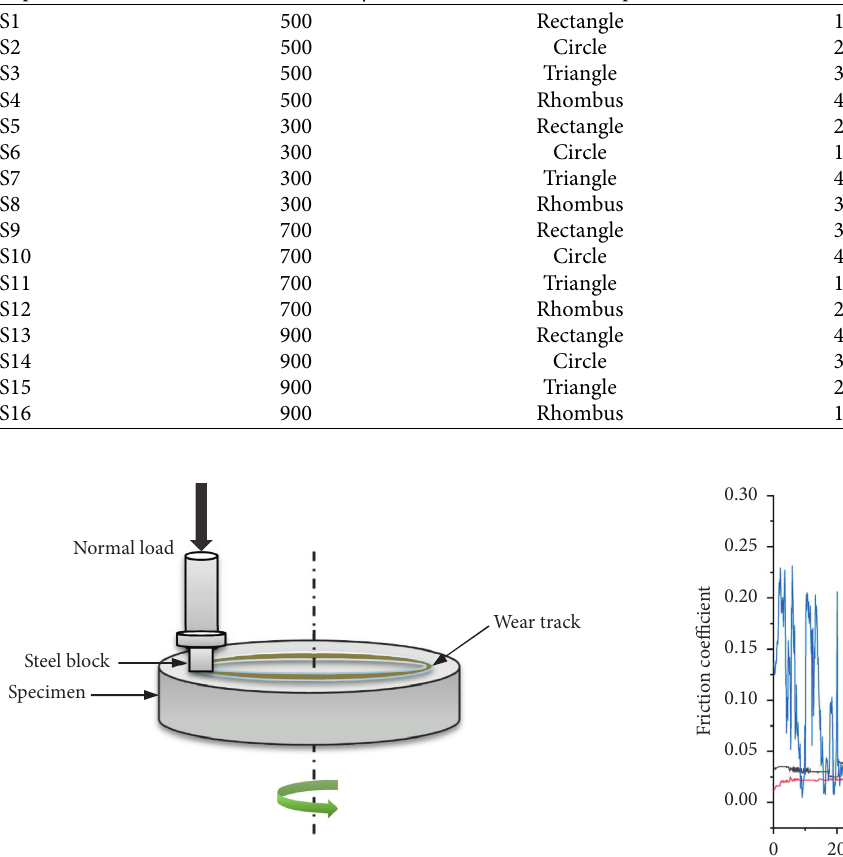
Figure 9: Schematic of the block-on-disc wear test.